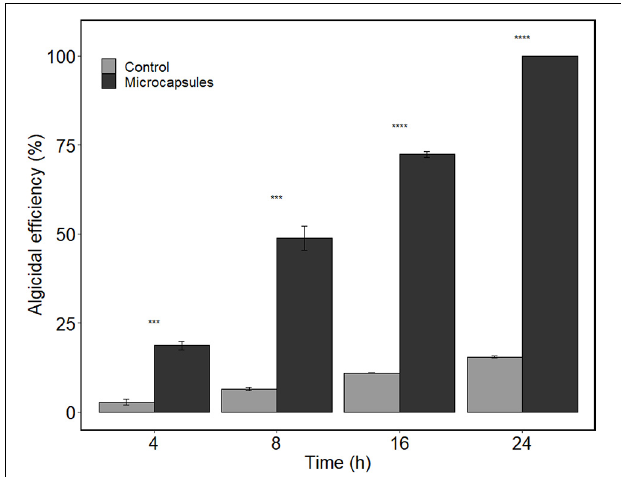
FIGURE 4 | Algicidal efficiency of the floating microcapsules against A. sanguinea. Controls are microcapsules without algicidal powder. Values are means ± s.e, n = 3. Asterisks “***” indicate p < 0.001 and “****” indicate p < 0.0001.